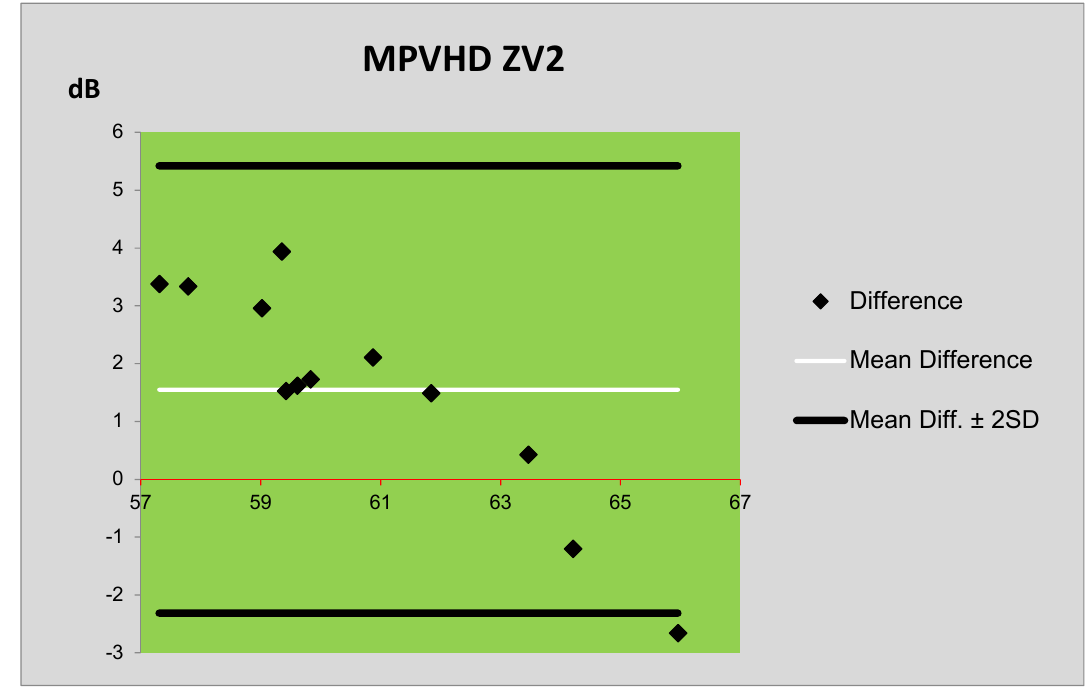
Figure 9. Plot of differences between the prediction (MPVHD) and measurement of ZV2.